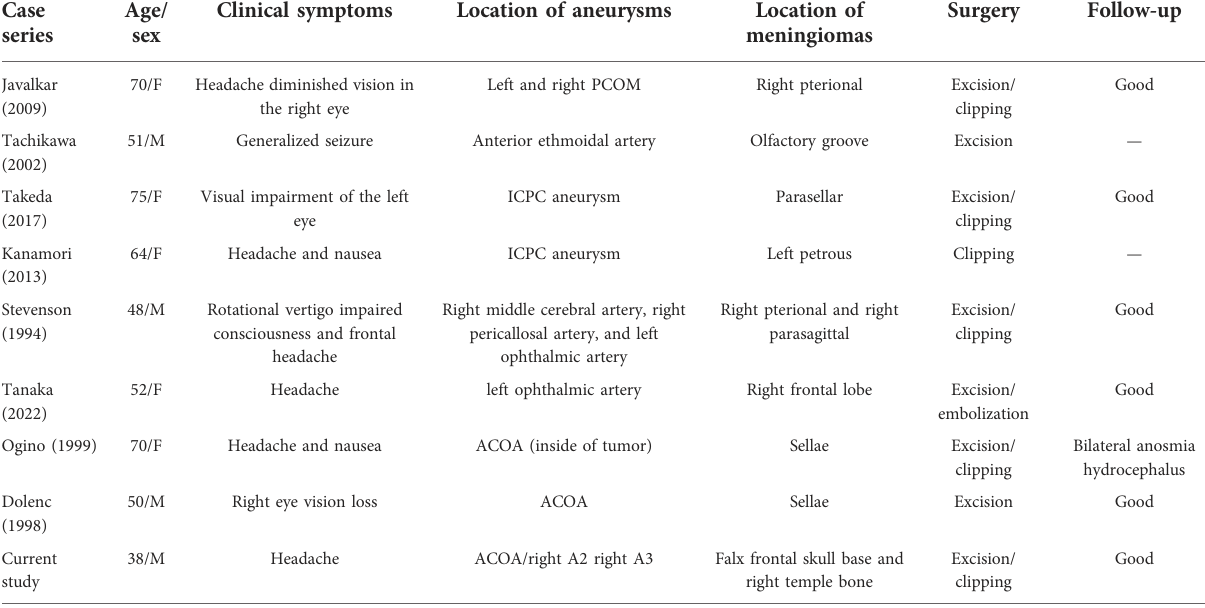
TABLE 1 Summary of nine cases with coexisting meningiomas and